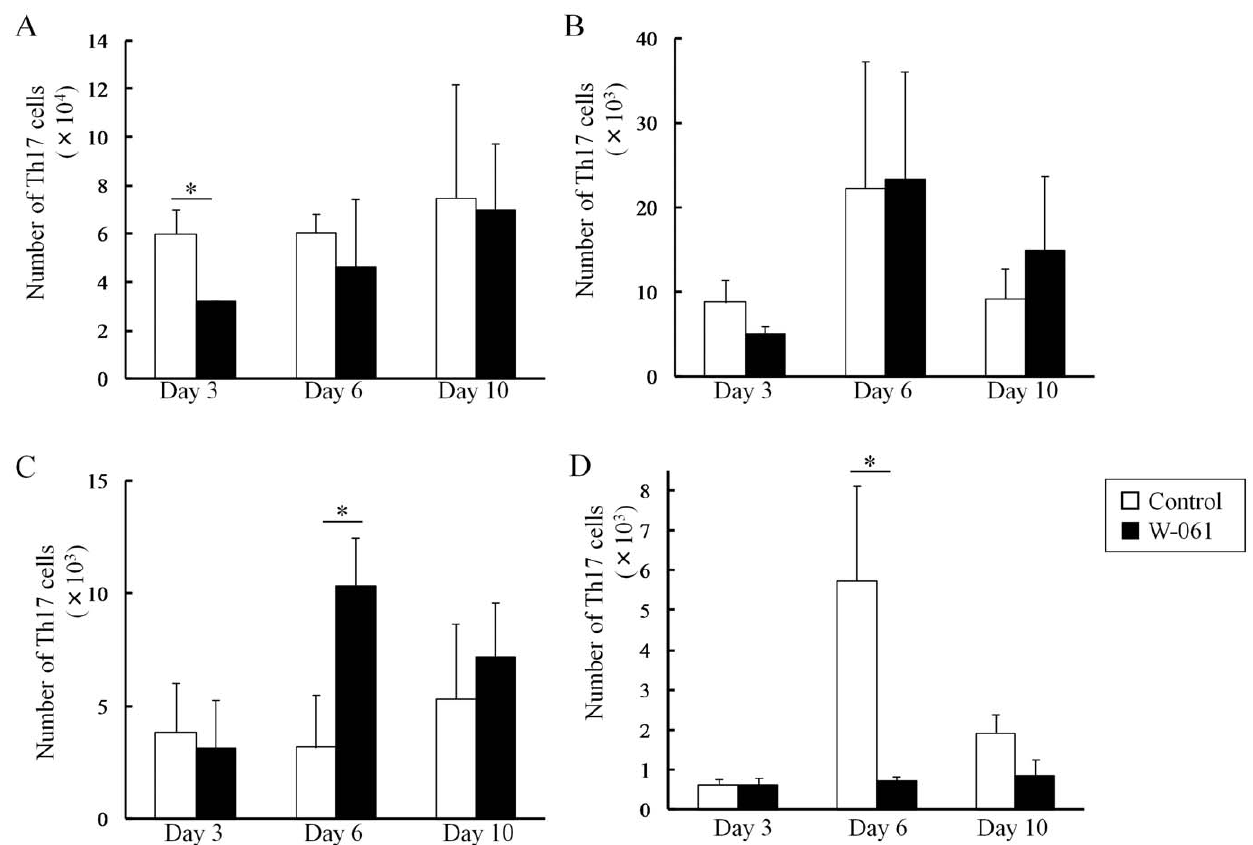
Figure 3. Change of the numbers of Th17 cells in (A) SP, (B) MLN, (C) PP and (D) LP. Data represent absolute values (means 6 SD, n=4 per group on days 3 and 6, n=6 per group on day 10, * p ,